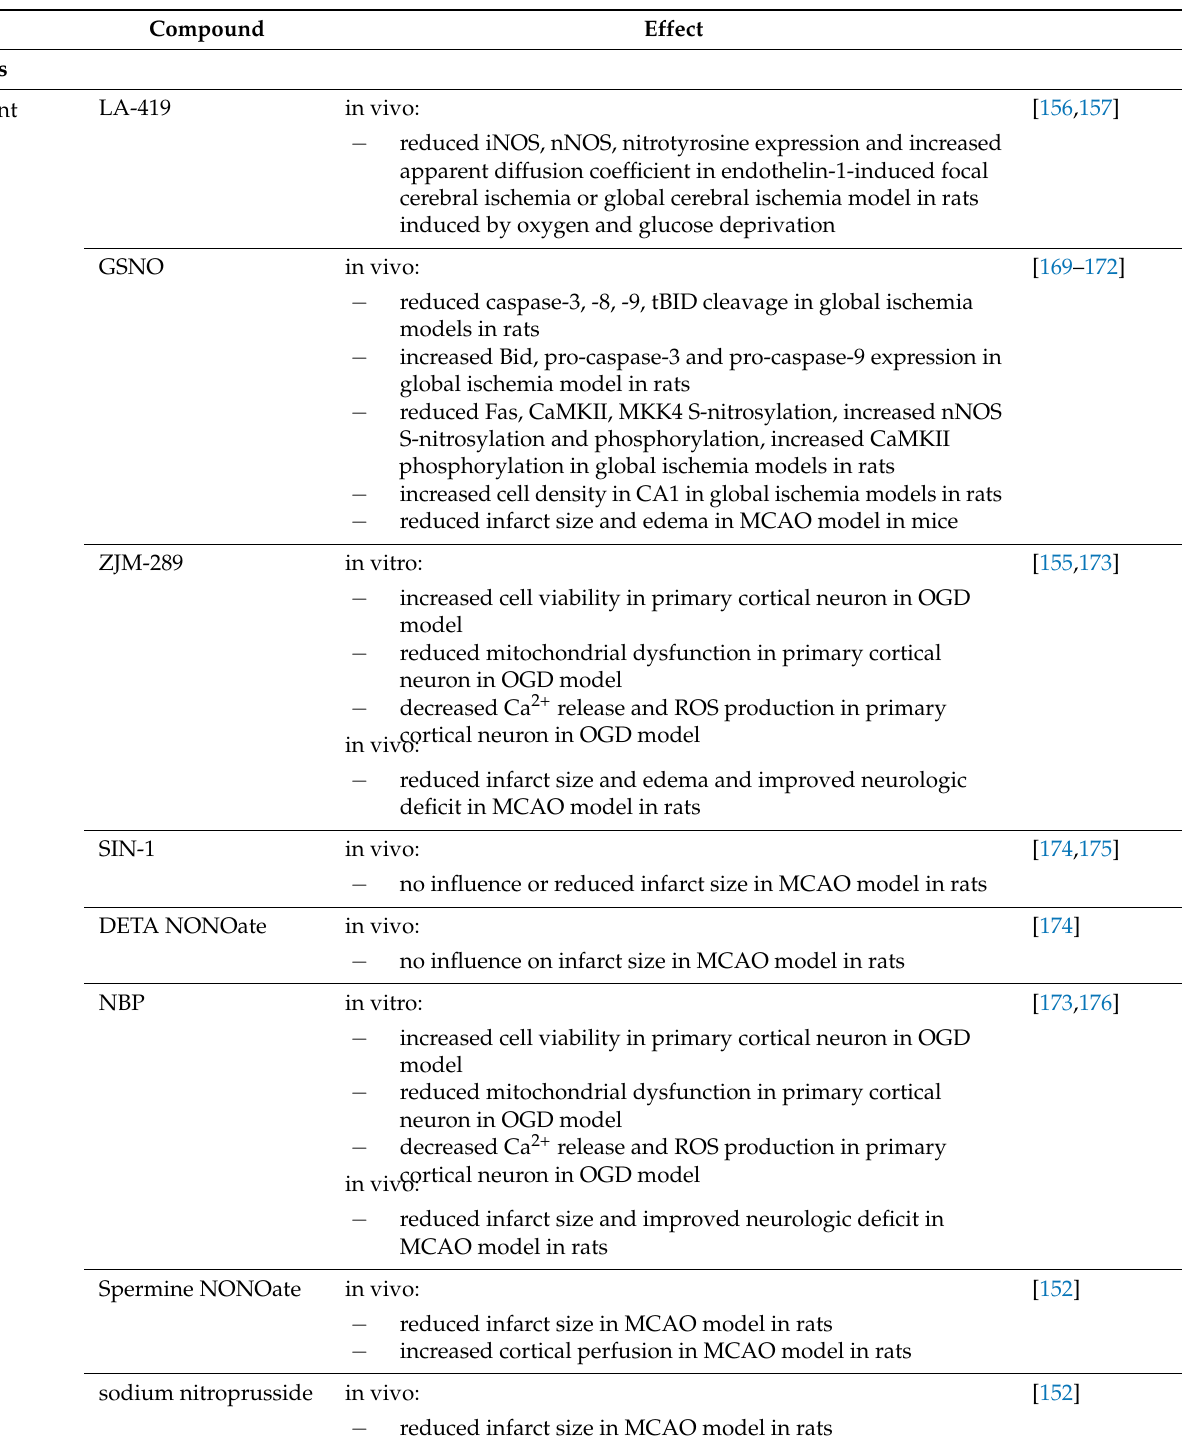
Table 1. Enhancement of NO • production and NOS inhibitor-based therapies. Pretreatment indicates that the compound was administered before experimental ischemia; posttreatment indicates that the compound was administered after the episode. MCAO—middle cerebral artery occlusion, ODG—oxygen and glucose